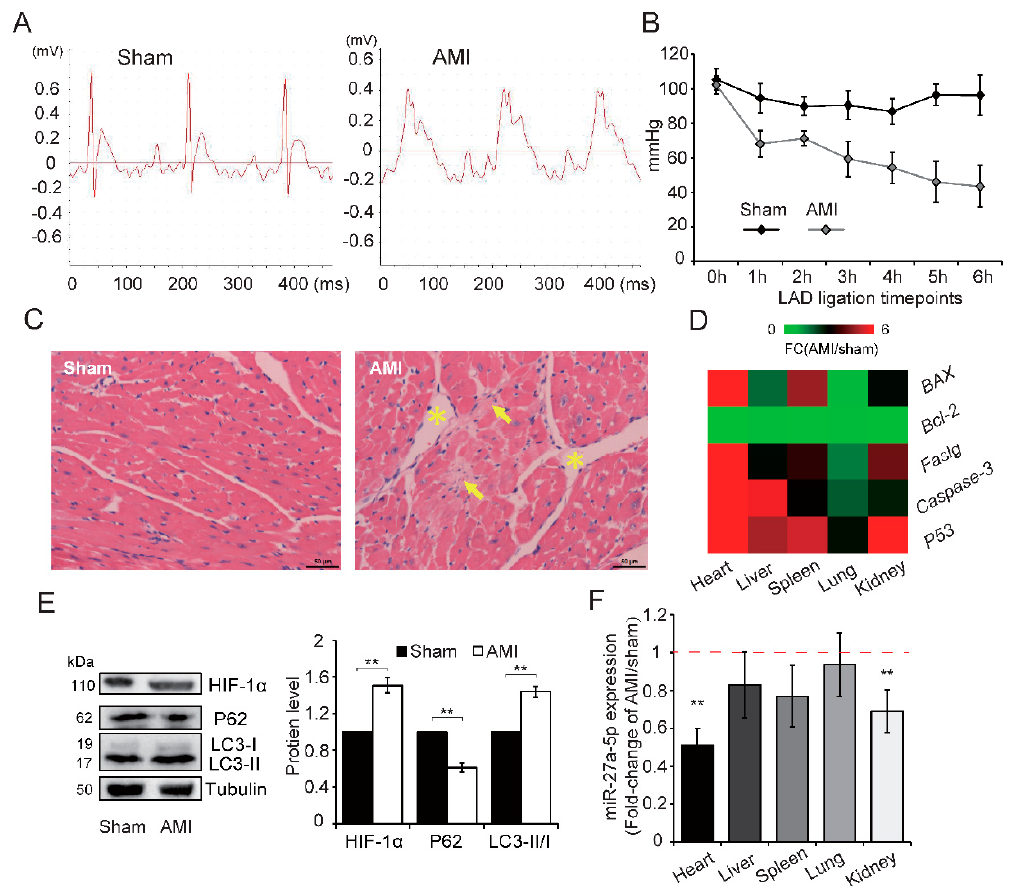
Figure 3. AMI widely induces injury and reduces miR-27a-5p expression in rats. A model of AMI was established in rats by ligating the coronary artery, and confirmed by analyzing ECG ( A ) and BP ( B ). ( C ) HE staining showed morphological di ff erences between sham and AMI rats in coronal sections of the left ventricle; Yellow arrowheads and asterisks highlight local necrosis and intercellular gaps, respectively; scale bar: 50 µ m. Expression patterns of apoptosis-related genes ( D ) in main visceral tissues (including heart, liver, spleen, lung and kidney) were determined by qRT-PCR (AMI vs Sham). AMI increased HIF-1 α expression and promoted the conversion of LC3-I to LC3-II, but decreased P62 expression ( E ). miR-27a-5p expression ( F ) in main visceral tissues by qRT-PCR analysis (AMI vs Sham). Data are presented as the means ± SD of three independent experiments. ** p < 0.01. LAD: left anterior descending coronary